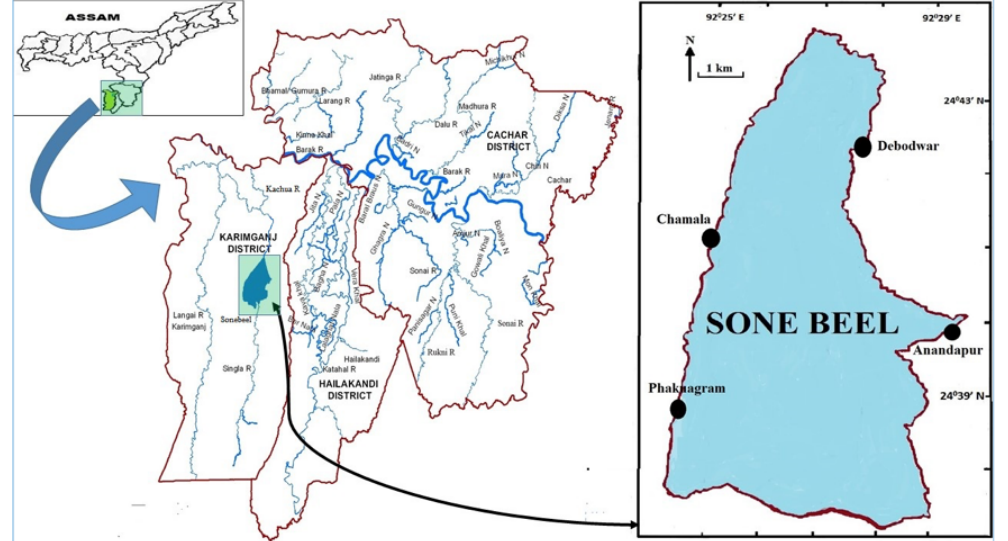
Figure 1. Map of Assam and Barak Valley showing Sonebeel and the four collection sites. (Map not up to